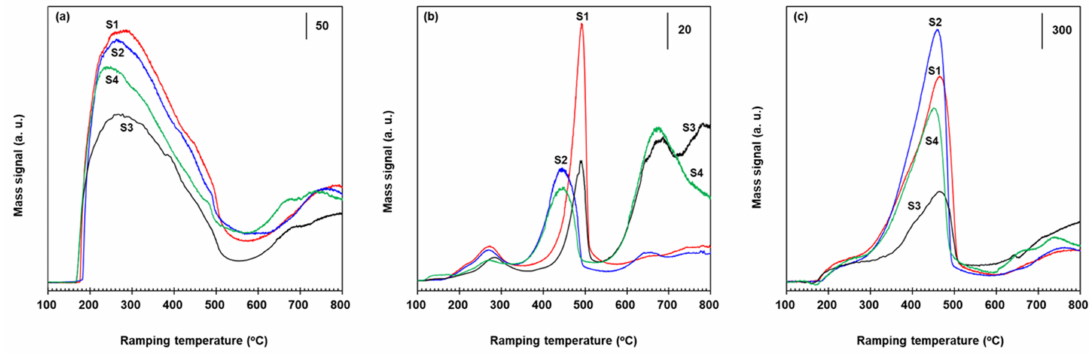
Figure 6. Mass spectra for the production of ( a ) NO, ( b ) N 2 O, and ( c ) N 2 in NH 3 TPD runs with unpromoted and promoted VWT-based catalysts. In ( a – c ), S1: VWT; S2: 2.73% Fe 2 O 3 /VWT; S3: c-VWT; S4: 2.73% Fe 2 O 3